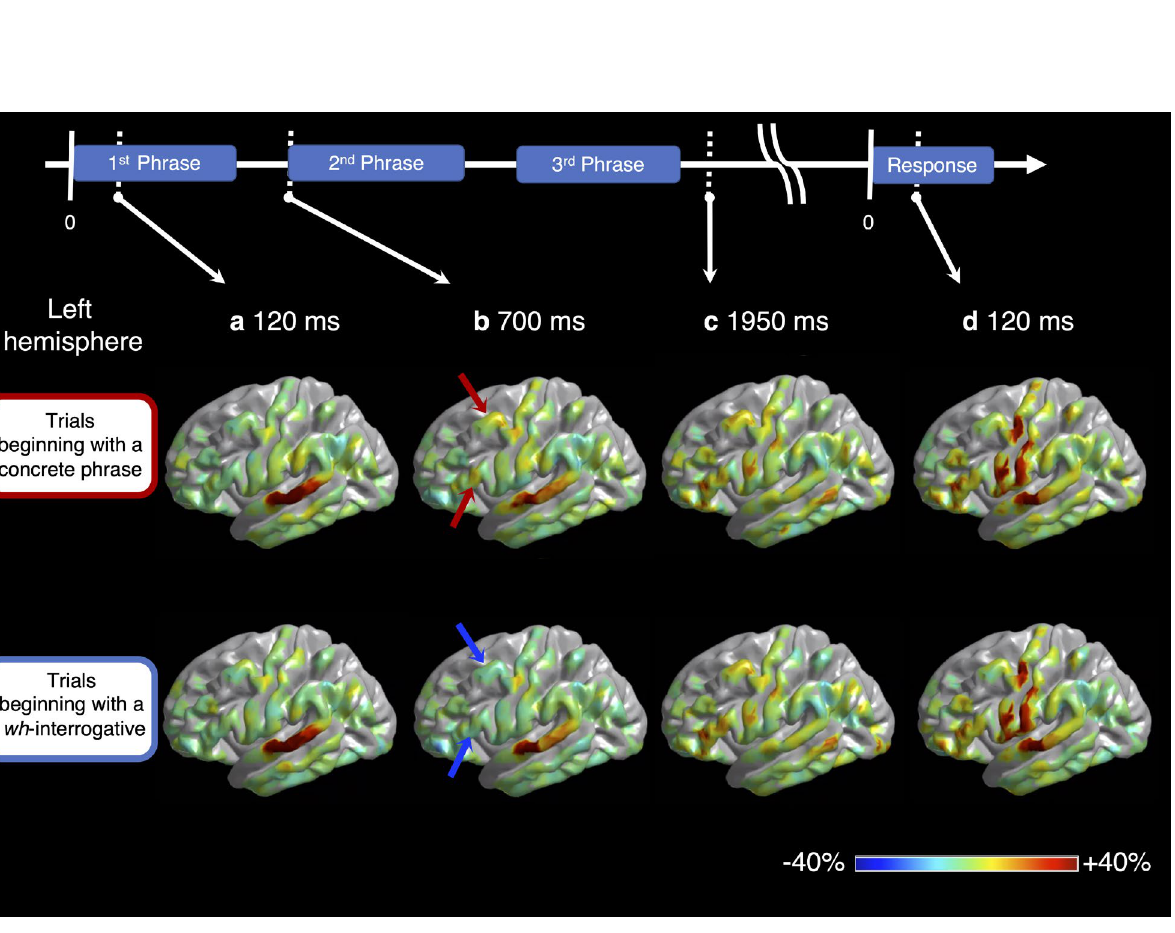
Figure 3. Snapshots of task-related high-gamma modulations. The video snapshots demonstrate the percent change of high-gamma activity relative to the baseline period (i.e., between − 600 and − 200 ms relative to stimulus onset). ( a ) At 120 ms following the 1st phrase onset, the bilateral superior-temporal gyri (STG) showed high-gamma augmentation. ( b ) At 700 ms following stimulus onset (i.e., after the 1st phrase offset), high- gamma activity in the left posterior prefrontal region was augmented during trials beginning with a concrete phrase (red arrow) but suppressed during those beginning with a wh-interrogative (blue arrow). ( c ) At 1,950 ms following the 1st phrase onset (i.e., after the 3rd phrase offset), high-gamma augmentation involved the left temporal and frontal lobe regions, extensively, commonly across the sentence types. ( d ) At 120 ms after response onset, high-gamma augmentation involved the Rolandic areas and STG